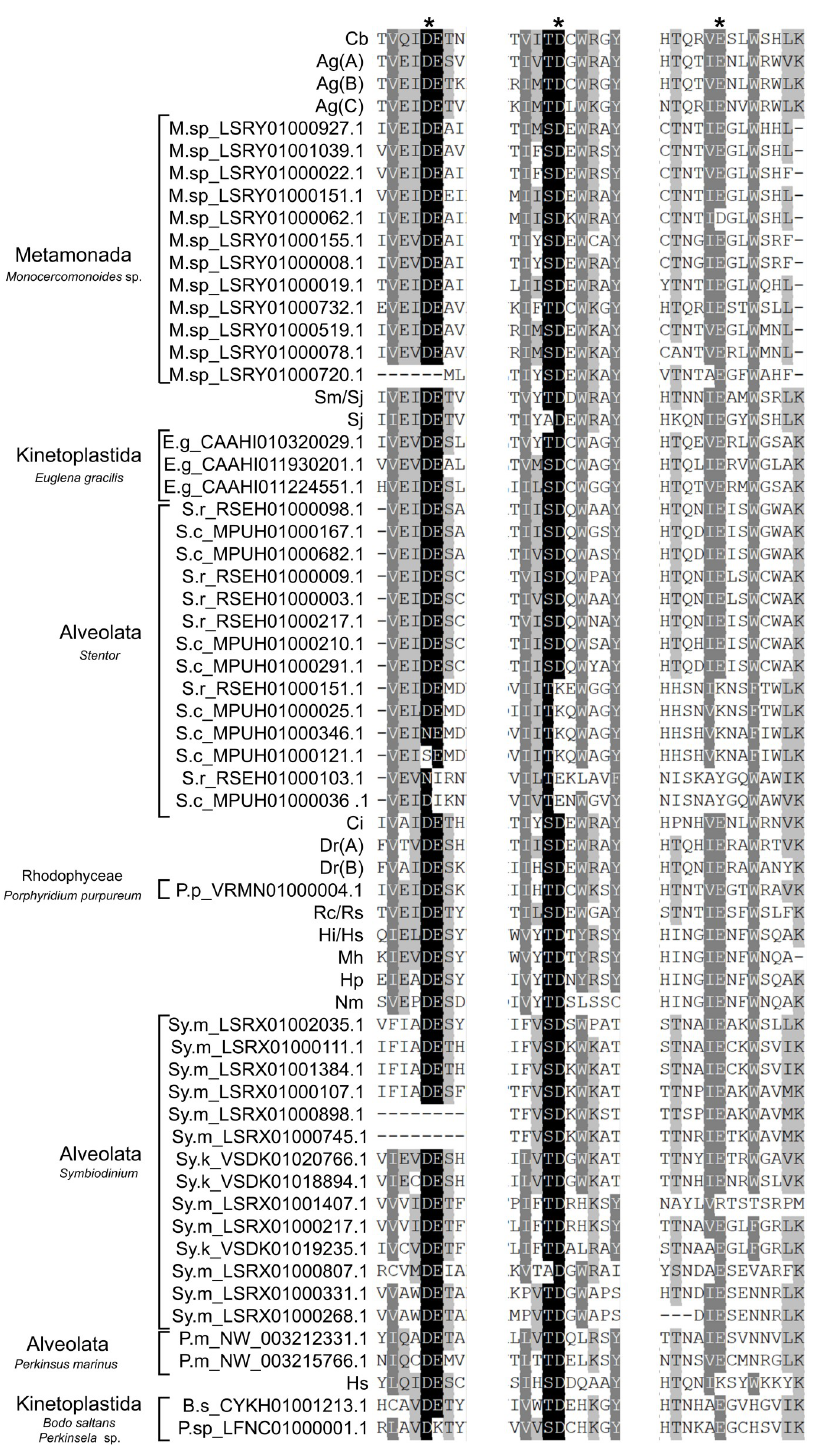
Fig 3. Alignment of the DDE catalytic motif region of Merlin families. The three conserved blocks of residues surrounding the DDE motif identified by Feschotte [14] are shown. The number of residues between blocks 1 and 2 varied from around 50 to 70 aa, except for the sequences Sy.m_LSRX01000331.1, Sy.m_LSRX01000268.1 and Sy. m_LSRX01000807.1 that present a larger region (around 110 aa). The DDE motif positions are highlighted with asterisks above the alignment. Colours on the sequences denote residues conservation: black > 90%; dark grey > 80%; light gray > 60%. All Merlin transposase proteins identified in this work were aligned with the Merlin sequence